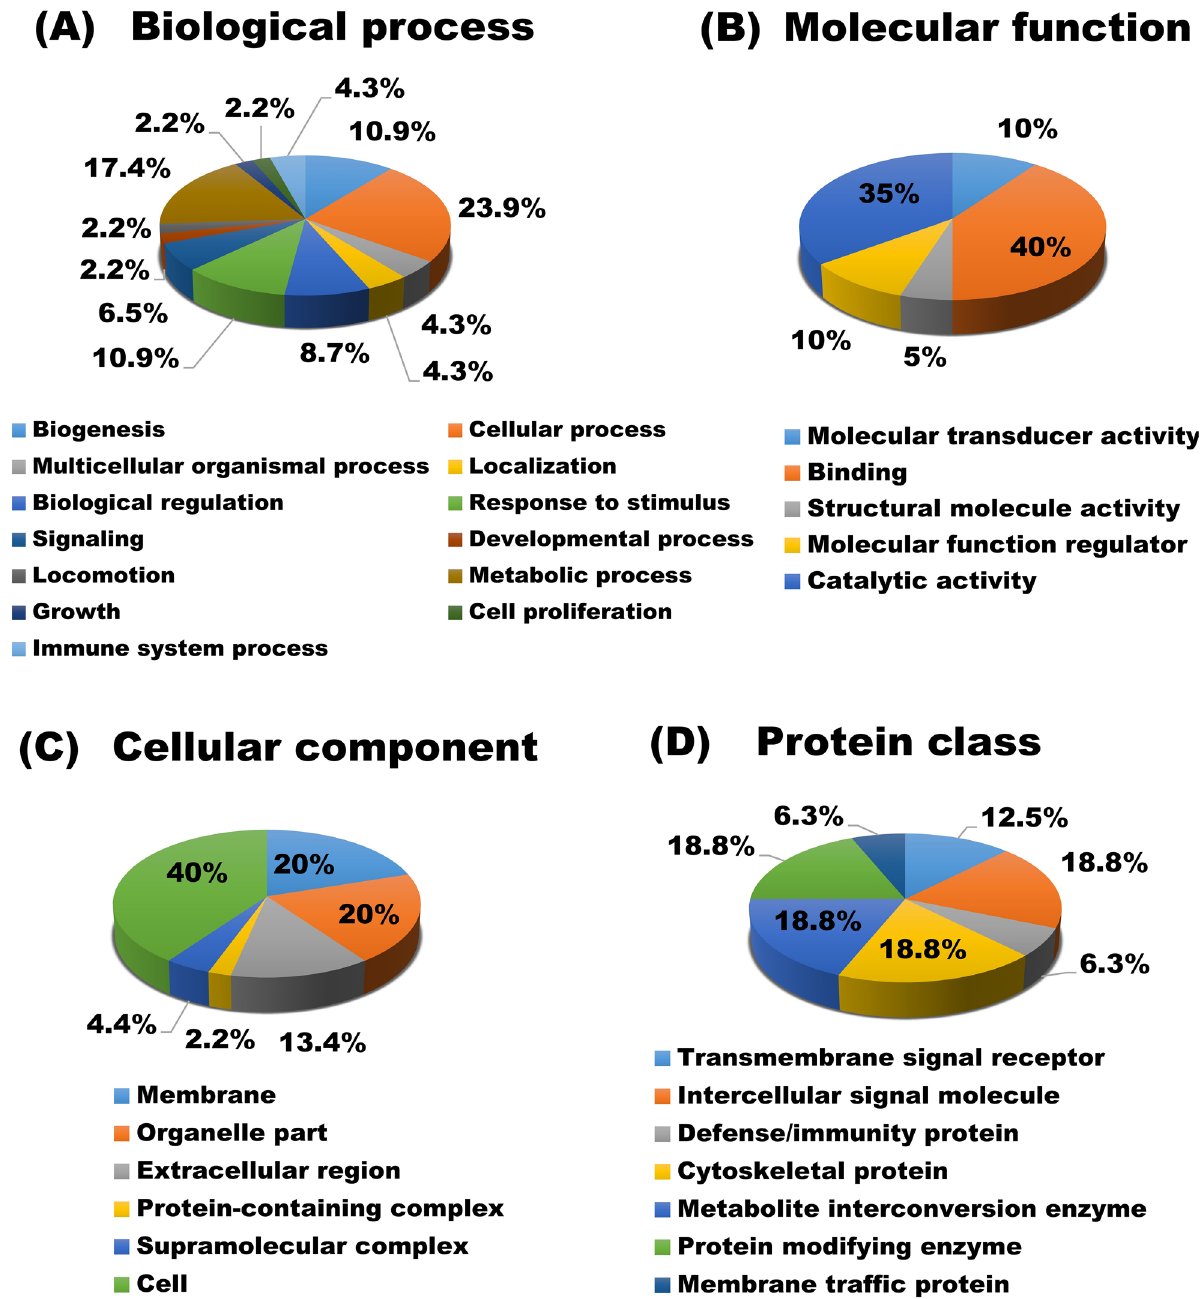
Figure 4. GO analysis of the candidates for differentially expressed proteins in milk sEV from BLV-infected cattle. The candidates for differentially expressed proteins in milk sEV from BLV-infected cattle were analysed using Panther software and categorised according to the biological process ( A ), molecular function ( B ), cellular component ( C ), and protein class ( D analysis revealed that the candidates for uniquely or differentially expressed proteins involved in many pathways including pathways in cancers, cytokine-cytokine interaction, PI3K-Akt signalling pathway, Jak-STAT signalling pathway, and focal adhesion. Several of these KEGG pathways played an important role in tumour cell prolifera- tion, metastasis, leukemogenesis as well as formation of solid tumours reported previously in human 34 . The results suggested that the biologically important pathways are probably involved in development and/or progression of BLV-induced leukemogenesis and tumour formation in cattle. Previous studies reported that mRNAs in milk and blood from BLV-infected cattle involved in diverse biological functions and many other pathways that are consistent with our current study 15,35 . In conclusion, proteomic analysis identified a total of 1330 common proteins in milk sEV from BLV-infected cattle, from which 118 proteins were the candidates for uniquely expressed proteins compared with those of